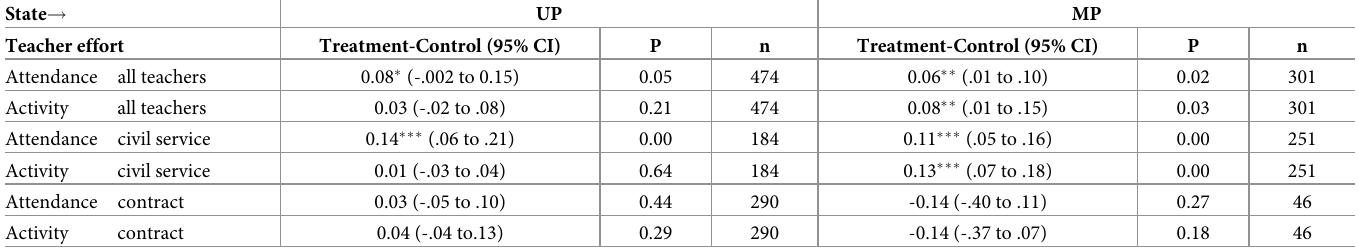
Table 2. Difference-in-differences linear regression results in MP and UP where change in outcome (teacher effort) from baseline to follow-up is dependent variable. State